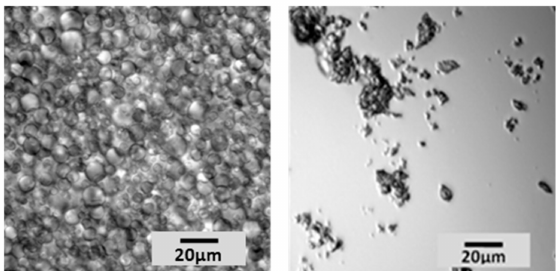
Figure 2. Microcapsules obtained after slurry lyophilisation ( left ) and the corresponding polymeric shells obtained after ball milling ( right